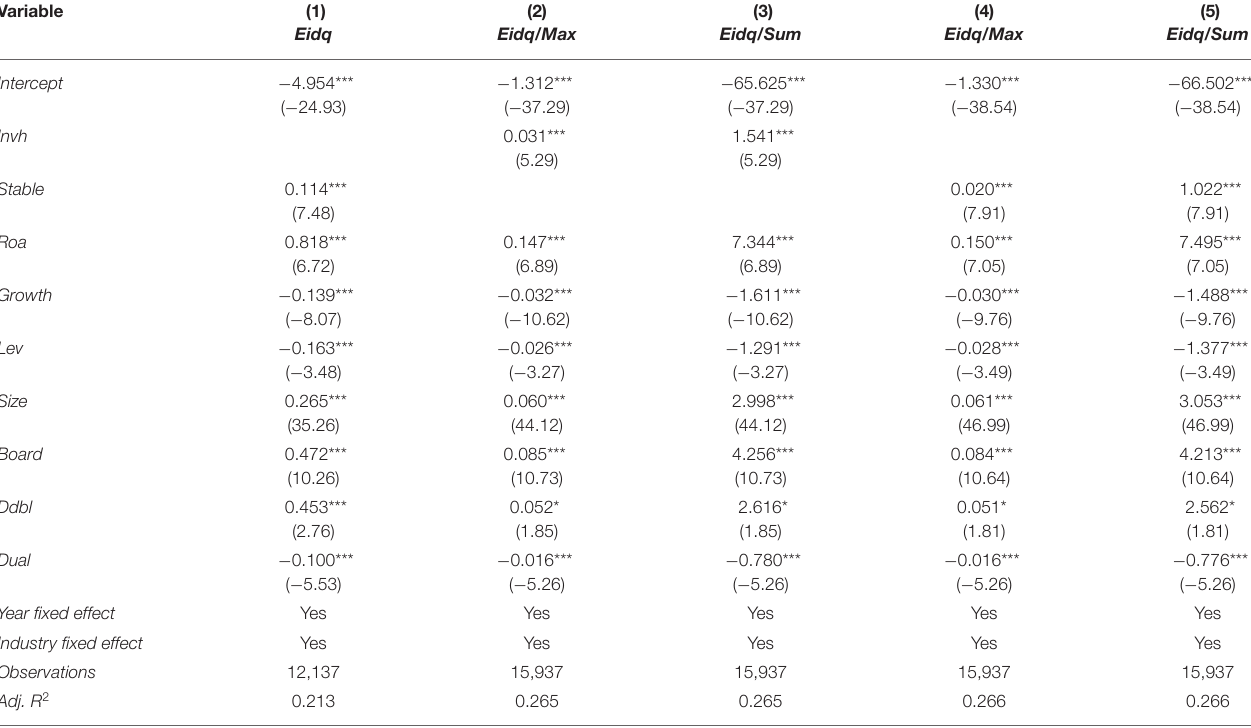
TABLE 7 | Institutional investors’ heterogeneity and environmental information disclosure quality: measurement indicator sensitivity tests.